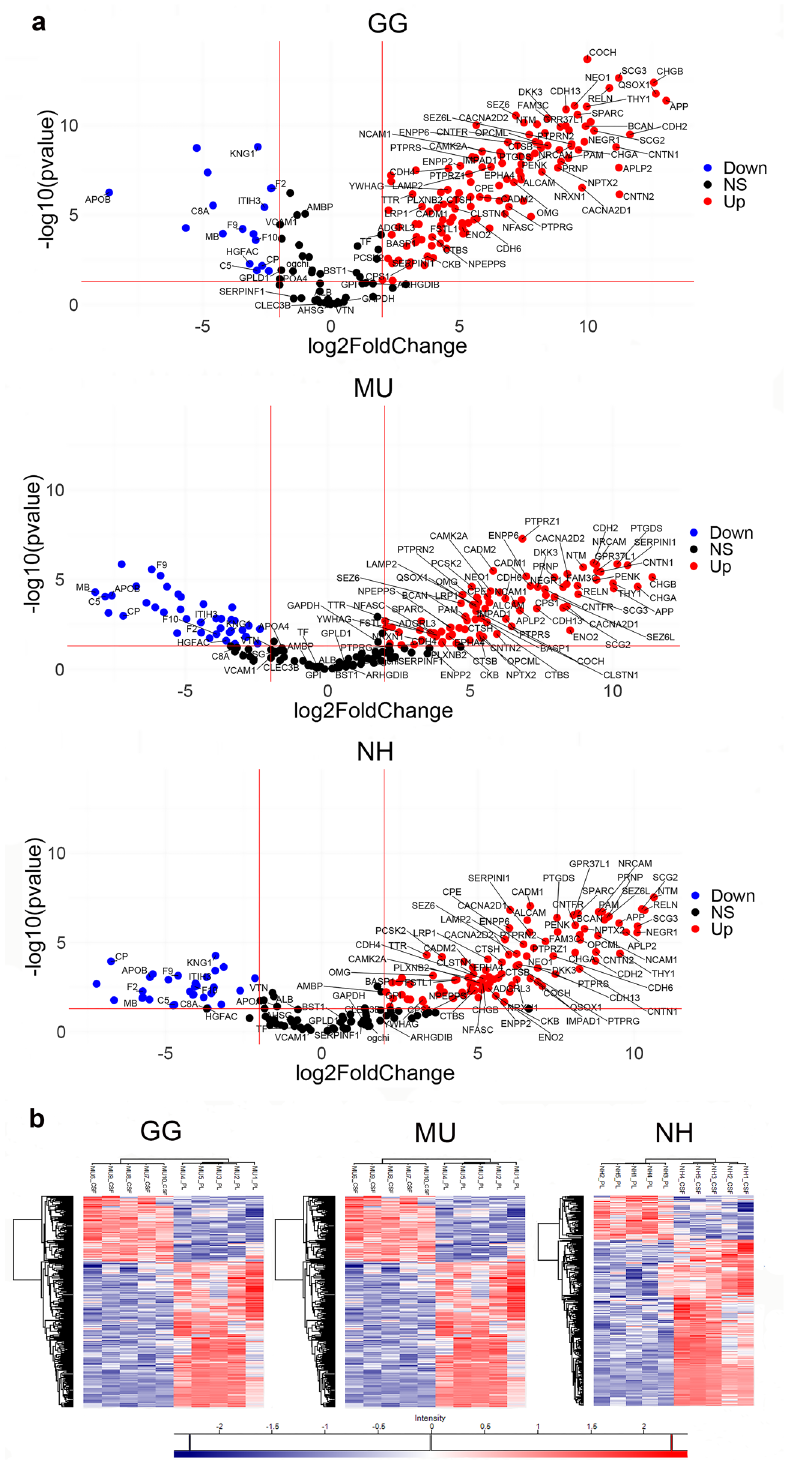
Figure 5. Comparative analyses of cerebrospinal fluid (CSF) and plasma (PL) proteomes. The distribution of the shared proteins across species and clustering of over-represented and down-represented proteins between the two fluids is shown in for chicken (GG), budgerigar (MU) and cockatiel (NH). ( a ) The volcano plots graphically demonstrate the fold changes on p values between CSF and PL proteomes that are shared across species, following Student t-tests corrected by the Permutation Based false-discovery rate (FDR) (FDR- adjusted p value < 0.05). The fold differences of the proteins (x-axis) dependent on their p values (y-axis) are shown in dots, colour- coded in blue, red and black, demonstrating the significantly under-represented proteins (Down), over-represented proteins (Up), and non-significantly represented proteins (NS, p < 0.05, fold change cut-off ≥ 2) respectively in CSF compared to PL for GG, MU and NH. The proteins that are commonly differentiated are indicated and labelled using their gene codes (R version 4.0.0, www.r-proje ct.org). ( b ) Hierarchical clustering heatmaps show differences in protein expression between CSF and PL in GG, MU and NH, respectively ( p < 0.05, after multiple testing). Proteins with high (red) and low (blue) expression form two clusters differentiating the fluids (Perseus version 1.6.10.50, http://www.perse us-frame